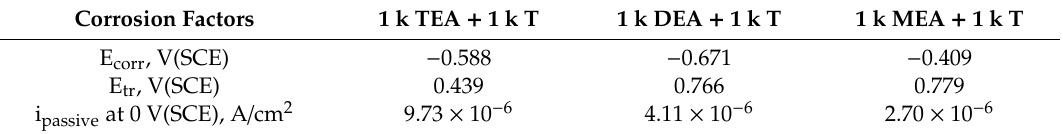
Figure 4. Effect of co-additive corrosion inhibitors on anodic polarization curve of DCI in deaerated [tap water + 1 k ppm tungstate (T) + 1 k ppm triethanolamine (TEA) or diethanolamine (DEA) or monoethanolamine (MEA)] at 30 °C. Table 3. Corrosion factors obtained from Figure 4 according to co-inhibitor composition.